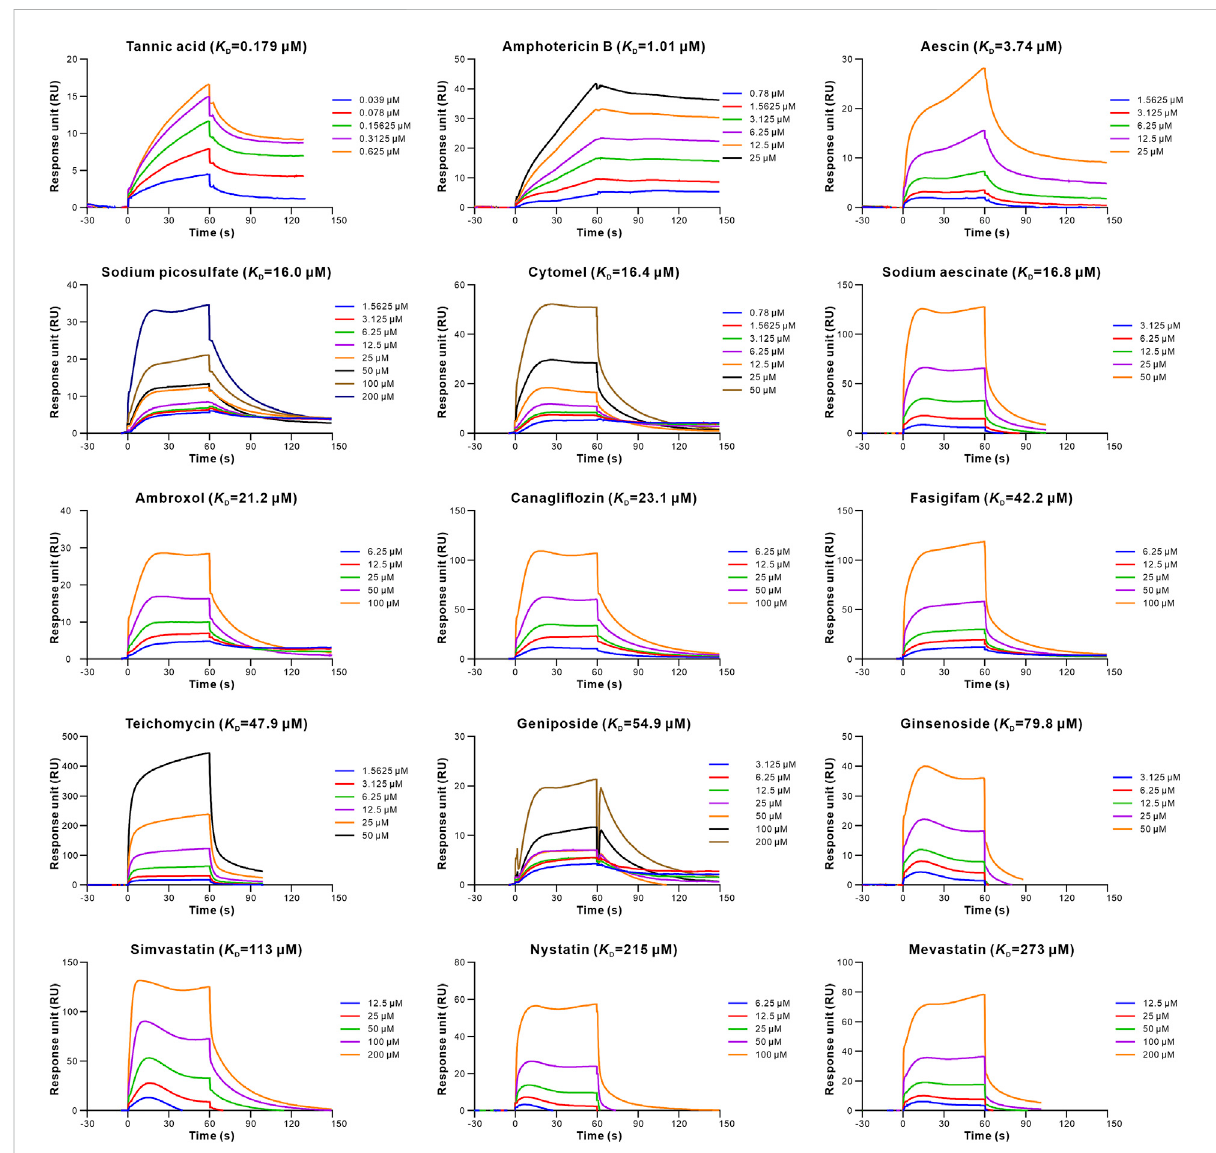
FIGURE 2 Binding of the retrieved drugs to SARS-CoV-2-RBD. SPR analysis was performed to assess the retrieved drugs binding to S-RBD at gradient concentrations.ThebindingcurveswereanalyzedusingakineticanalysissuppliedwithBiacoreEvaluationSoftware.Dataarepresentedasresponse units (RU) over time (s). The K D were calculated by using a 1:1 binding